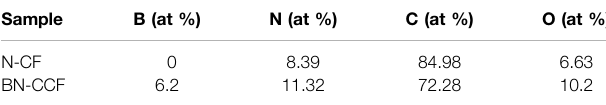
TABLE 2 | Contents of B, N, C, and O in N-CF and BN-CCF. Sample